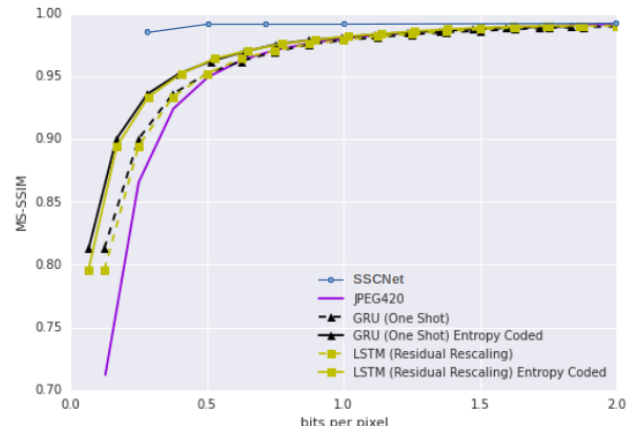
Figure 4. Rate distortion curve on the Kodak dataset using MS-SSIM as evaluation metric over bits per pixel. We show all the results reported by [25] demonstrate the reconstruction capability of the SSCNet using 3 channels dataset. We highlight our use of Imagenet-ILSVRC2012 as the training set and Kodak as the test